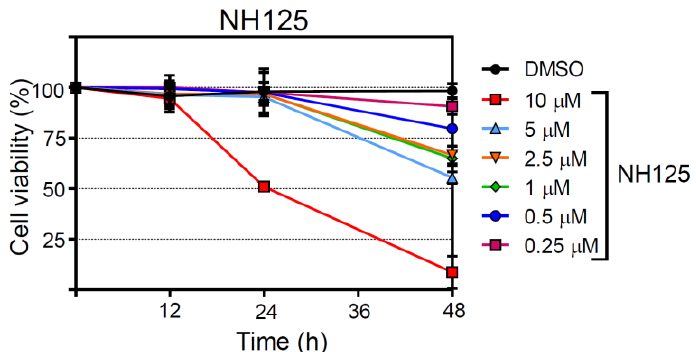
Figure 6. Assessment of the cytotoxic properties of NH125. BHK-21 cells were incubated with either DMSO or NH125 using the indicated concentrations. The proportion of dead cells was determined at the indicated times by determining the activity of dead cell protease released from dying cells and in total cell lysates. Mean values and standard deviations of 4 parallel experiments are shown.